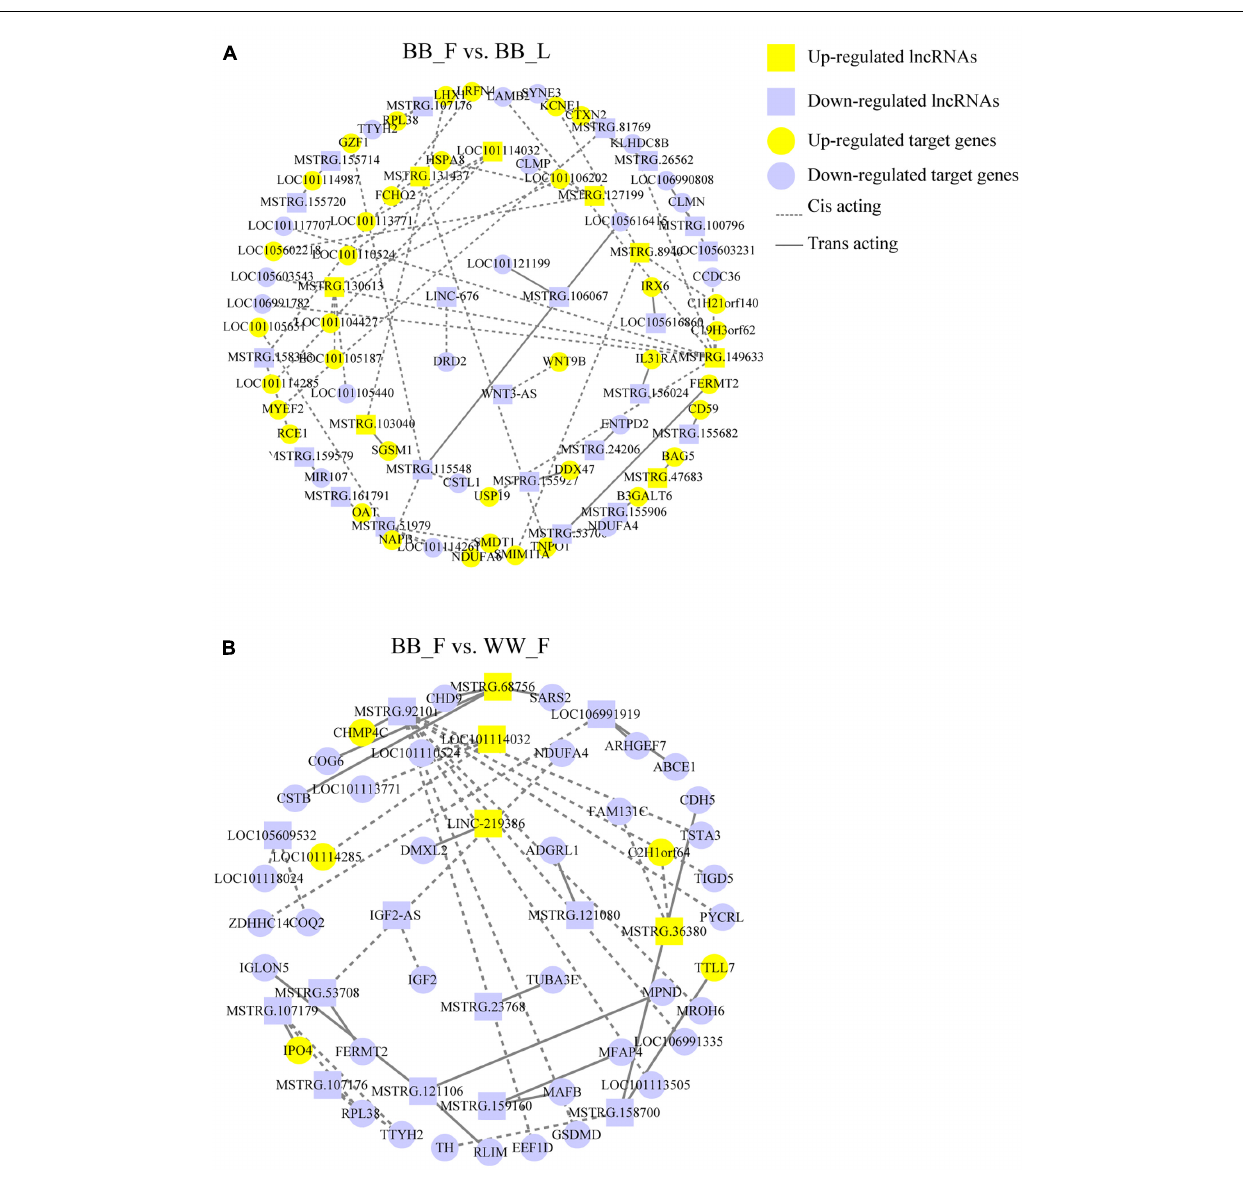
FIGURE 4 | DELs interaction with protein-coding genes consist of network. (A) In the BB_F vs. BB_L, 29 DELs are cis- acting or trans- acting with 58 mRNAs, which build the interactive network. The yellow and purple colors are for upregulated and downregulated lncRNA and target genes, respectively. Rectangles and ellipses are for lncRNA and target gene, respectively. The dotted and straight lines are for cis- acting and trans- acting, respectively. (B) In the BB_F vs. WW_F, 14 DELs are cis- acting or trans- acting with 42 mRNAs, which build the interactive